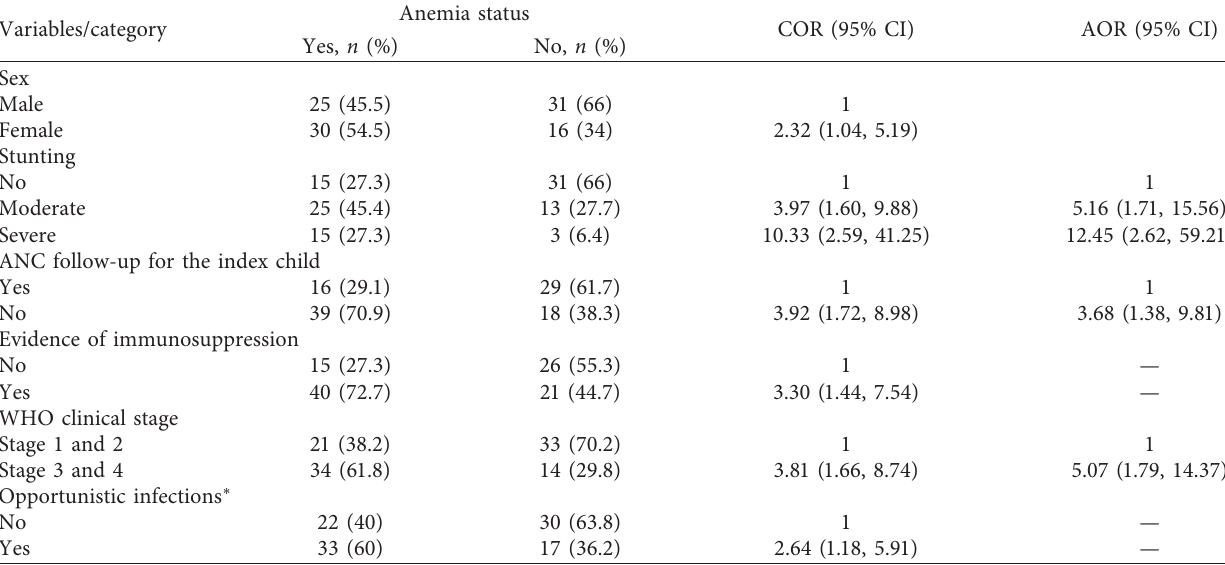
Table 6: Factors associated with anemia status of HIV-infected children aged 6 months to 15 years, in the Afar region, Ethiopia, 2018.